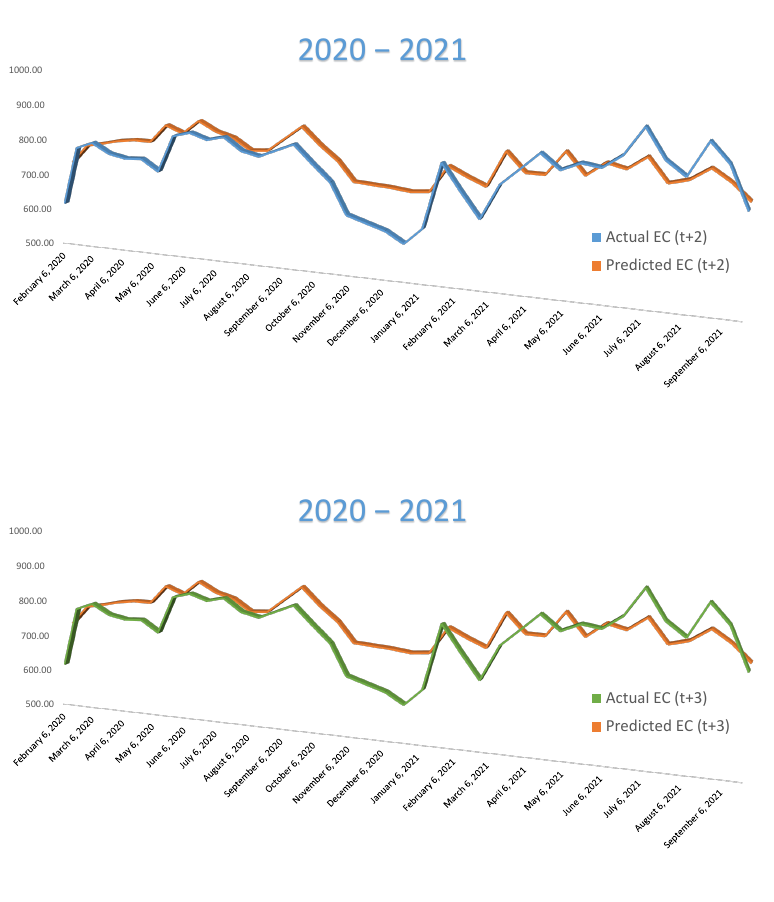
Figure 9. Test data results of Bi–LSTM model for multi–step (t + 1, t + 2, t + 3) forecasts of the optically active parameter EC for the years 2020 and